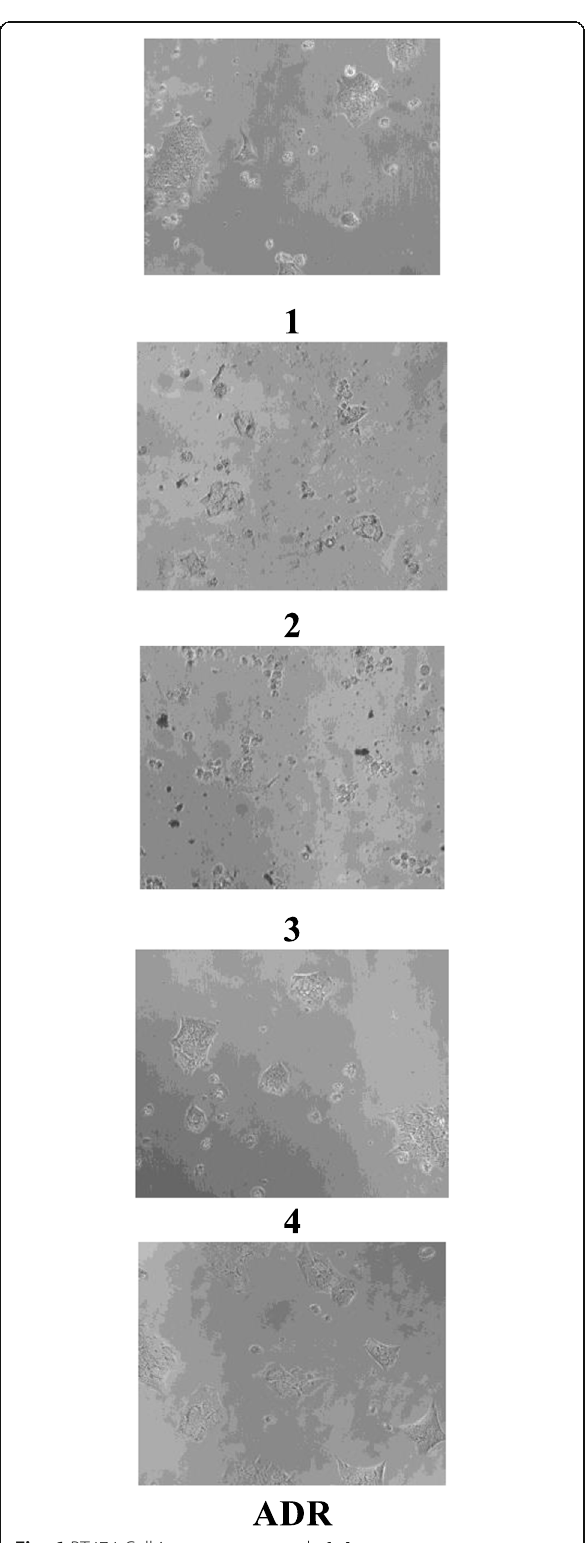
Fig. 5 HOP 62 Cell images compounds 1 - 4 Fig. 6 BT474 Cell images compounds